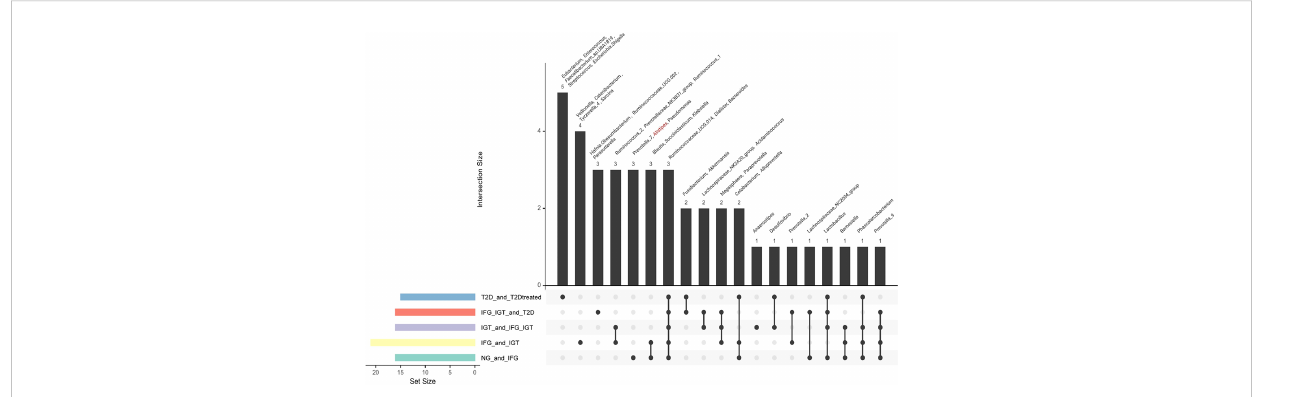
FIGURE 5 A multidimensional approach to interlace nodes information obtained with the differentially abundance tool (EdgeR) and driver nodes (Netshift). For both EdgeR and Netshift, the data was obtained from pairwise comparisons along with the cohort. NG vs IFG, IFG vs IGT, IGT vs IFG_IGT, IFG_IGT vs T2D and T2D vs T2D treated. *Note: In red were marked genera that had “ driver node ” characteristic from NetShift